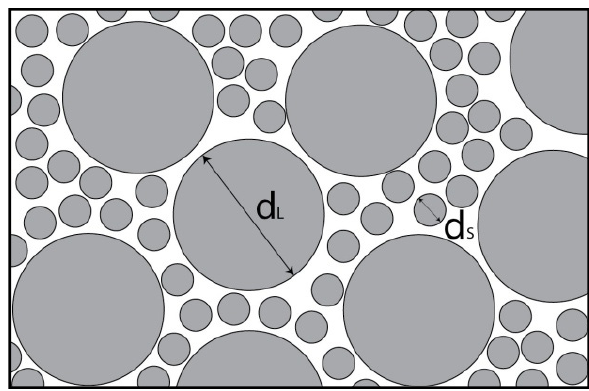
Figure 1. Spatial distribution of spherical particles in a bimodal suspension.